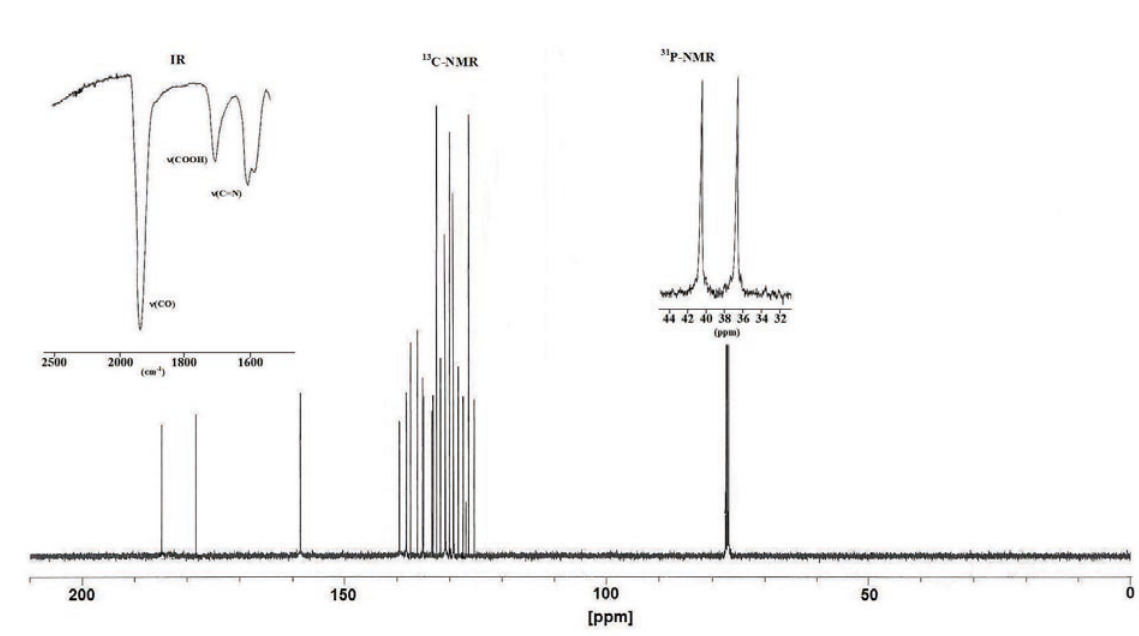
Figure 1. IR, 13 C and 31 P-NMR spectral features of compound